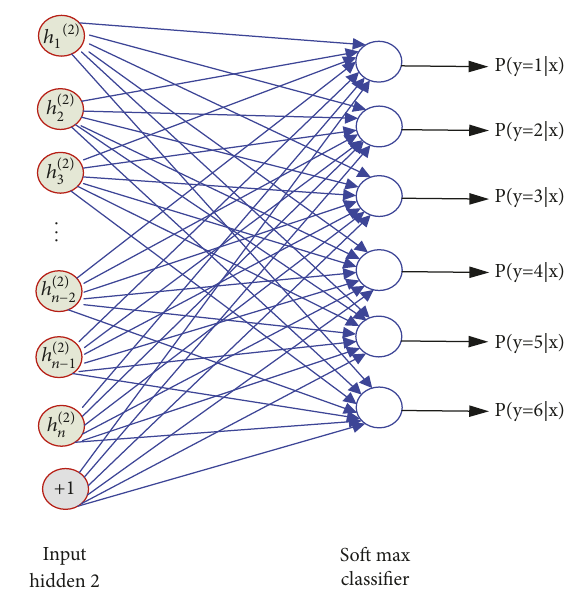
Figure 6: Training of hidden layer 2.